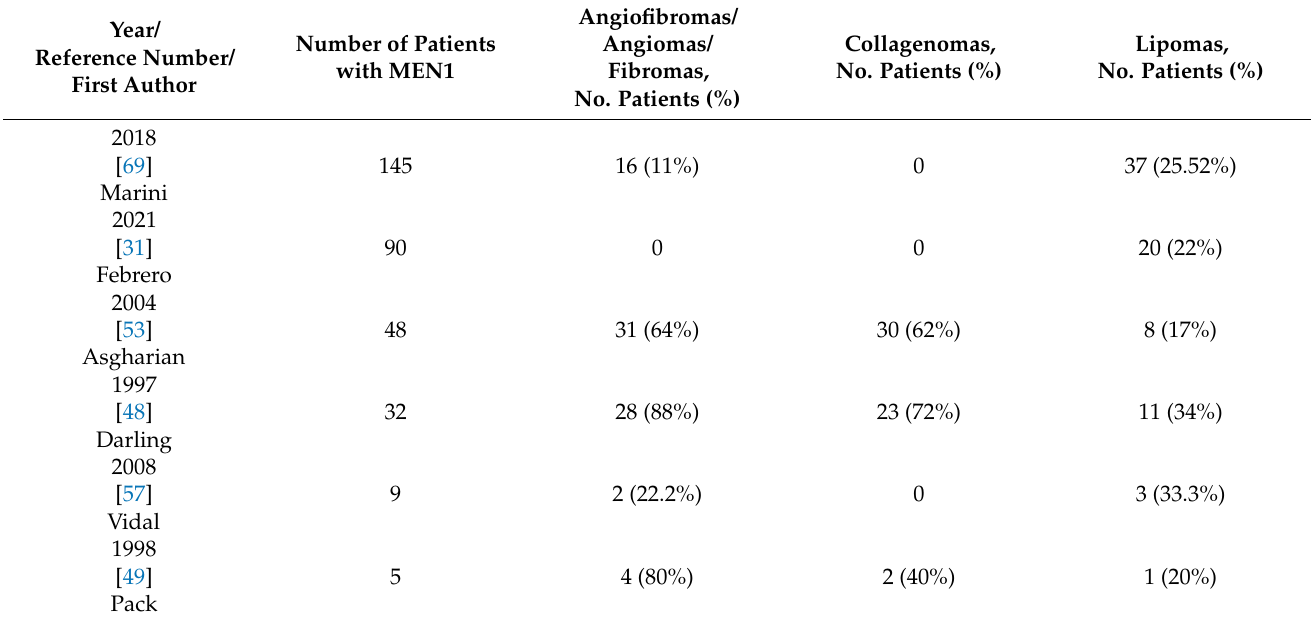
Table 2. Prevalence of cutaneous tumors in MEN1 patients as reported by largest studies in terms of number of patients diagnosed with the syndrome. Please see references